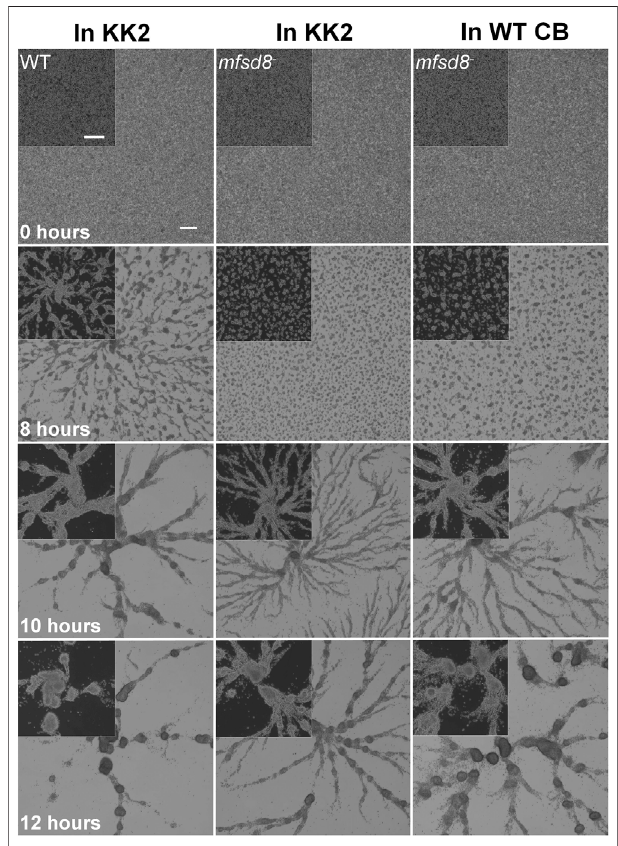
FIGURE 6 | Effect of conditioned buffer on the aggregation of mfsd8 −